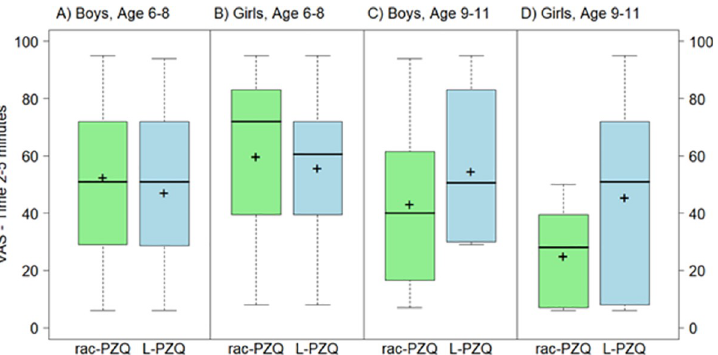
Fig 4. Boxplot of VAS scores (mm) for L-PZQ ODT and Rac-PZQ ODT without water at time 2–5 minutes, by gender and age. Dark lines indicate median values; ’+’ indicate mean values; the boxes represent the middle 50% of data with the bottom and top of the box represent the first and third quartiles (interquartile range, IQR); the whisker lines above and below the boxes represented the largest and smallest values that are not considered to be outliers; outliers are values that are 1.5 times the IQR below the first quartile or above the third quartile and are denoted with an open circle.